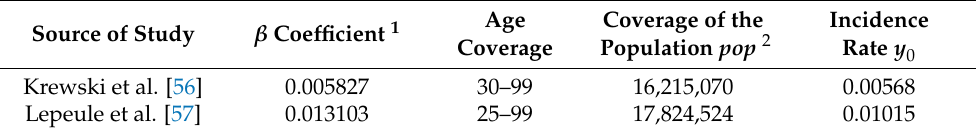
Table 5. Data used to compute the expectation of mortality in the health impact analysis. Source of